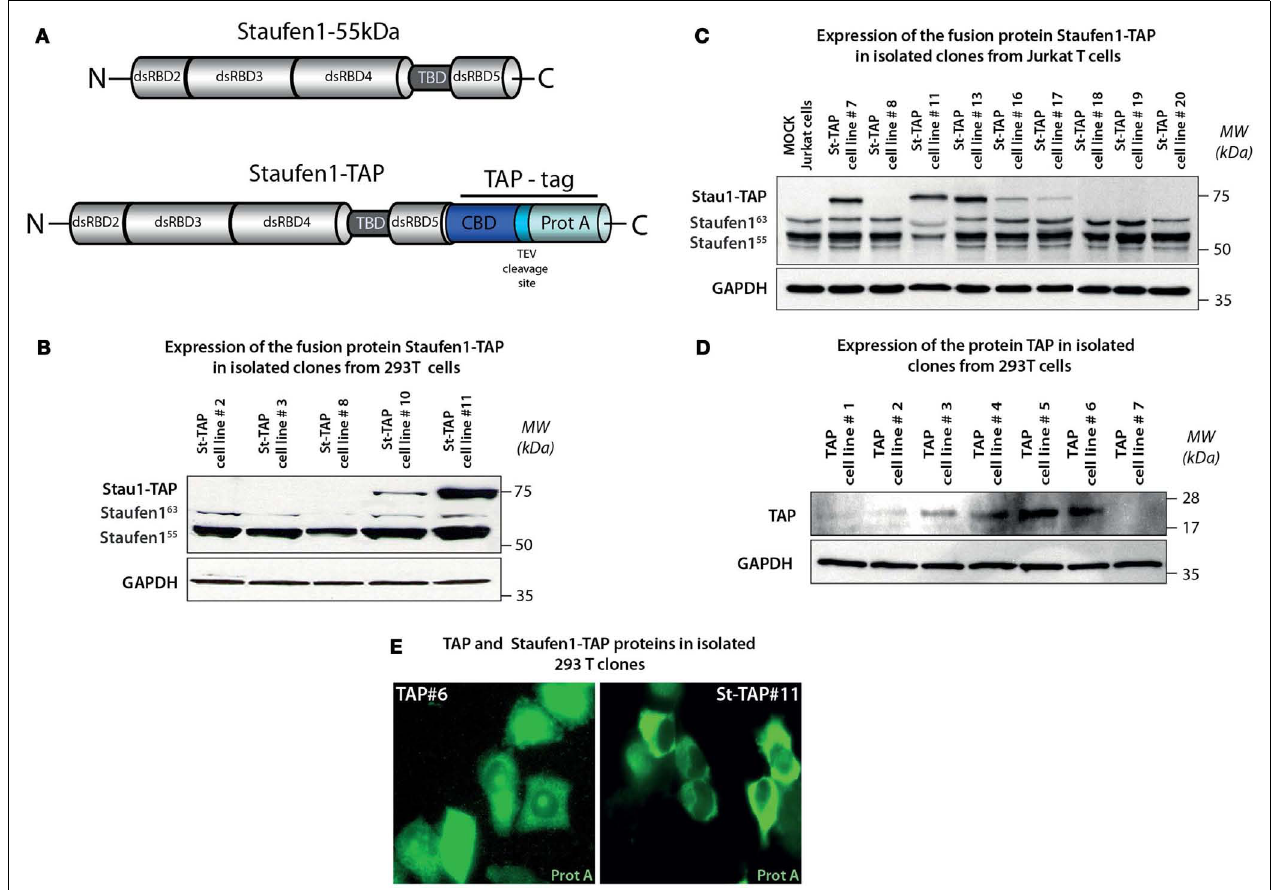
(63kDa), the endogenous isoforms and exogenous St-TAP ( ∼ 75kDa) fusion protein, respectively. GAPDH is the loading control. 293T cell clone #11 and JurkatT cell clone #13 were used in experiments. (D) Expression levels of TAP protein in 7 (#1–#7) control 293T clones and verified by western blotting. Clone #6 was used in control experiments. (E) Stable cell lines TAP#6 and St-TAP#11 were stained with mouse monoclonal anti-protein A antibody.The primary antibody was detected by Alexa Fluor 488 goat anti–mouse IgG antibody and the stained cells were visualized by epifluorescence